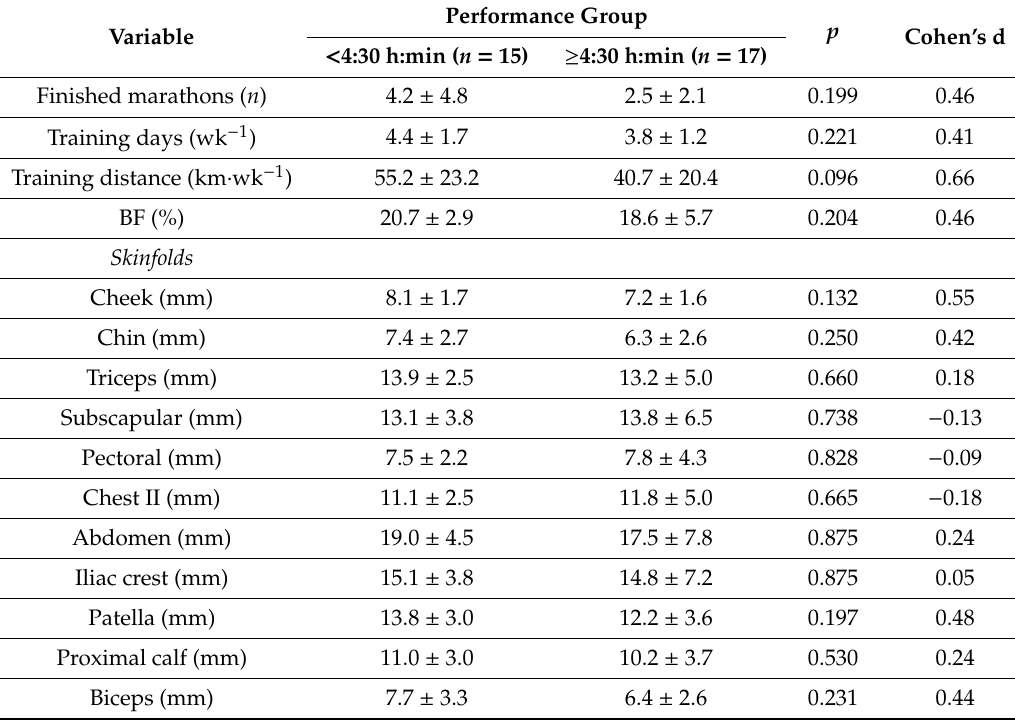
Table 3. Anthropometric characteristics and body composition of female participants by performance level.